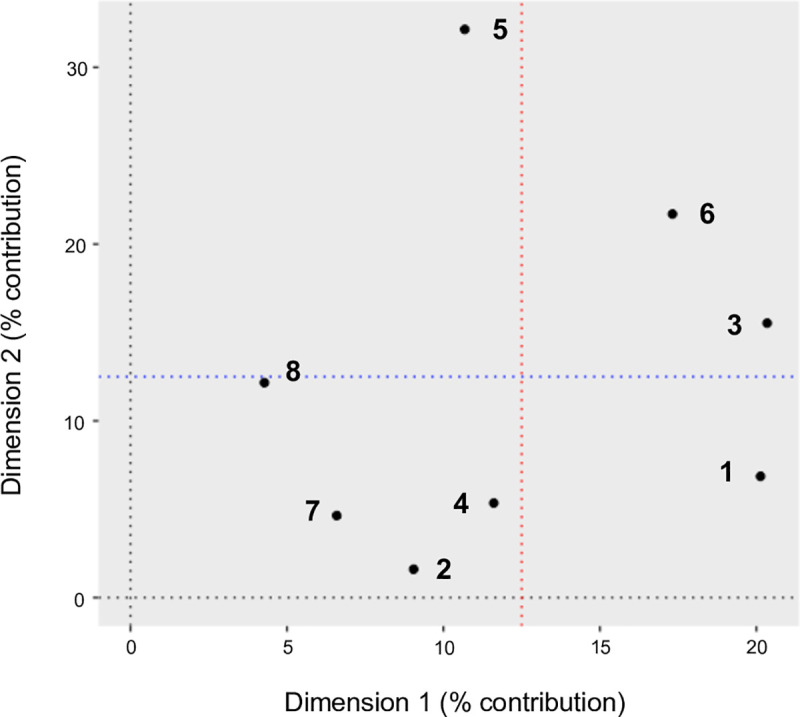
Percent contribution of each group to the first (Dimension 1) and second (Dimension 2) factors derived from MFA performed on characteristics of livestock-keeping households in northern Tanzania.Red (blue) dotted line represents the expected score if all domains contributed equally to the inertia on the first (second) factor (i.e. 100/8 = 12.5%).